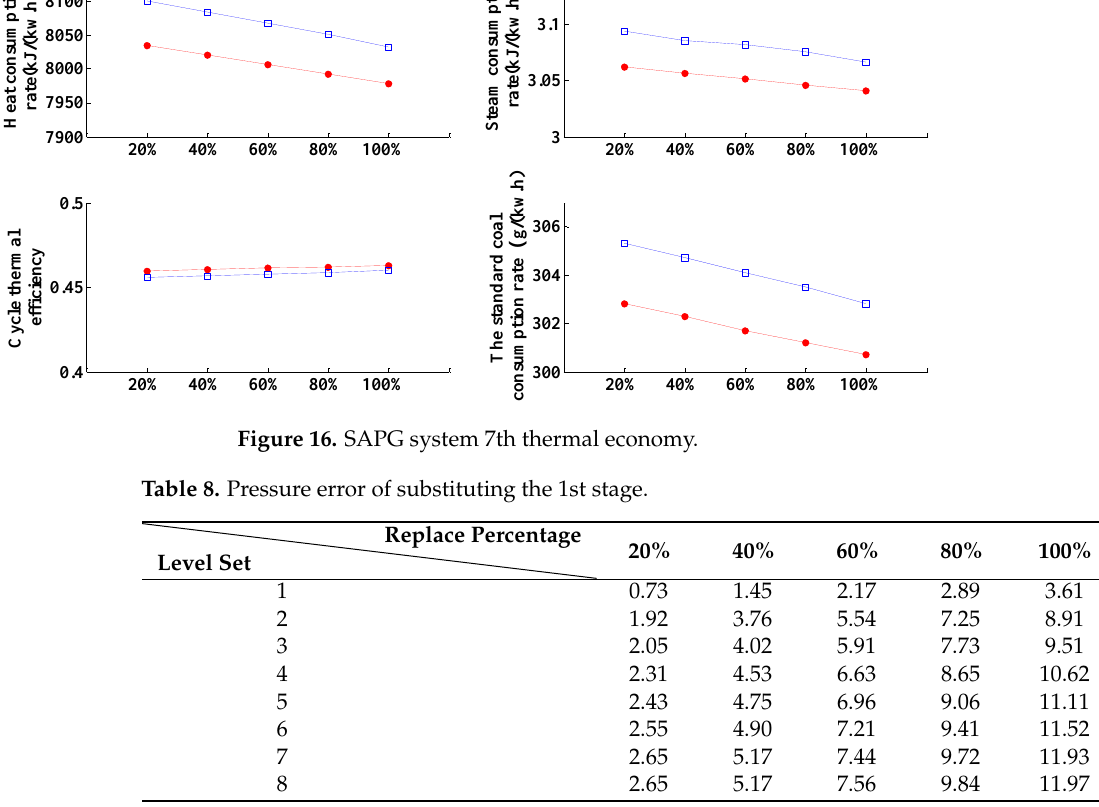
Figure 15. SAPG system 6th thermal economy.